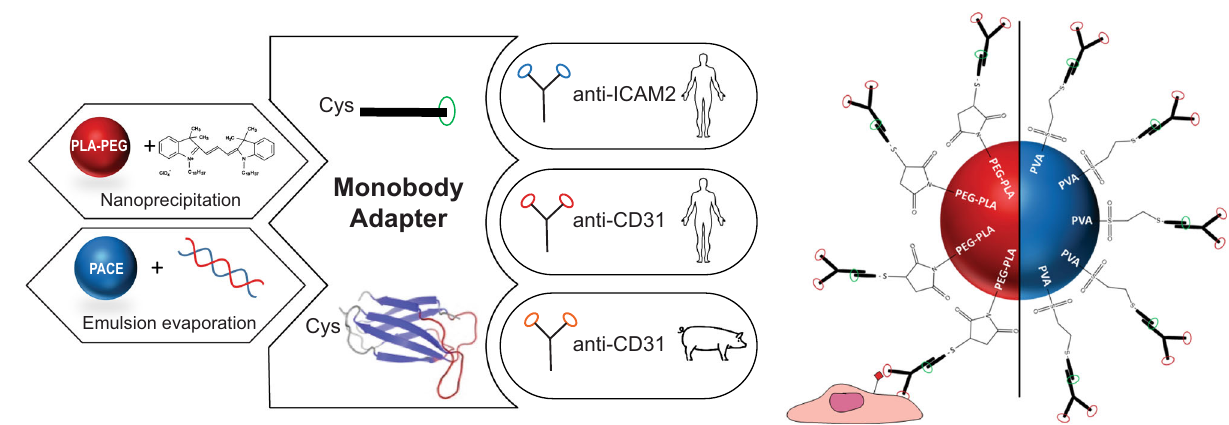
Fig. 6 | Summary schematic of targeting strategy using the monobody adapter. PACE Poly(amine-co-ester), PVA Poly(vinyl alcohol), VS vinyl sulfone.